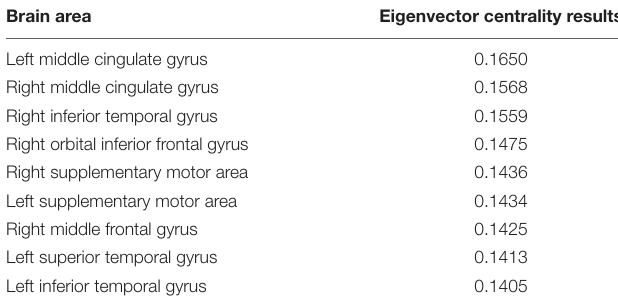
TABLE 2 | Eigenvector centrality